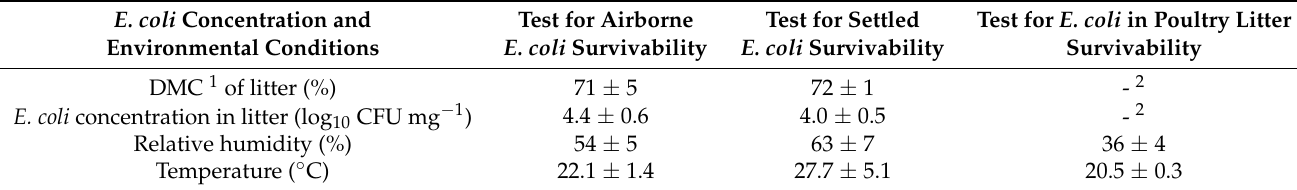
Table 1. Conditions (Mean ± SD) for the E. coli in survivability test.